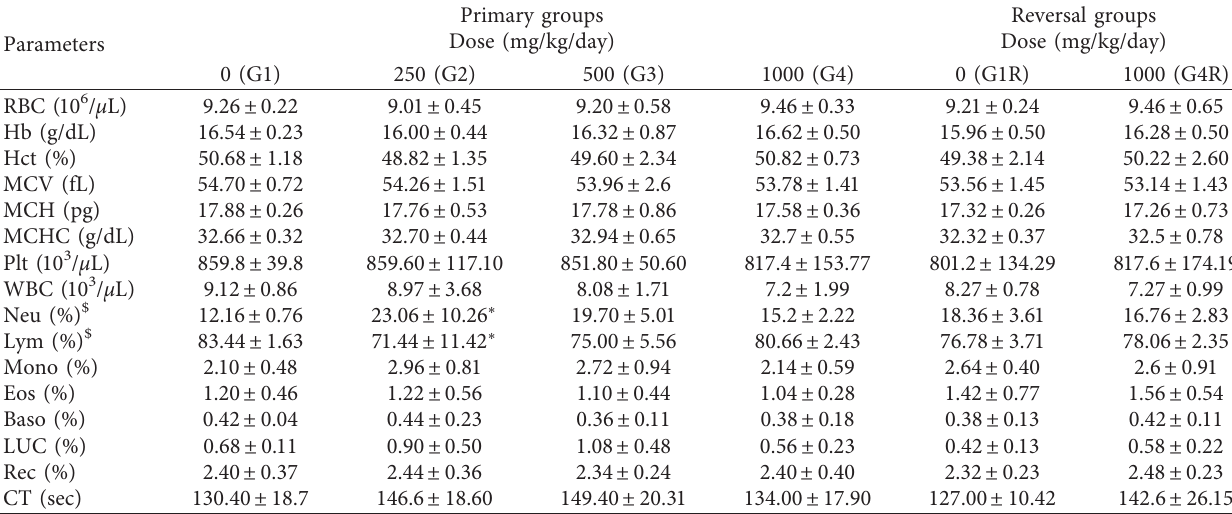
Table 7: Effect of oral administration of GMCT on hematology parameters in male Wistar